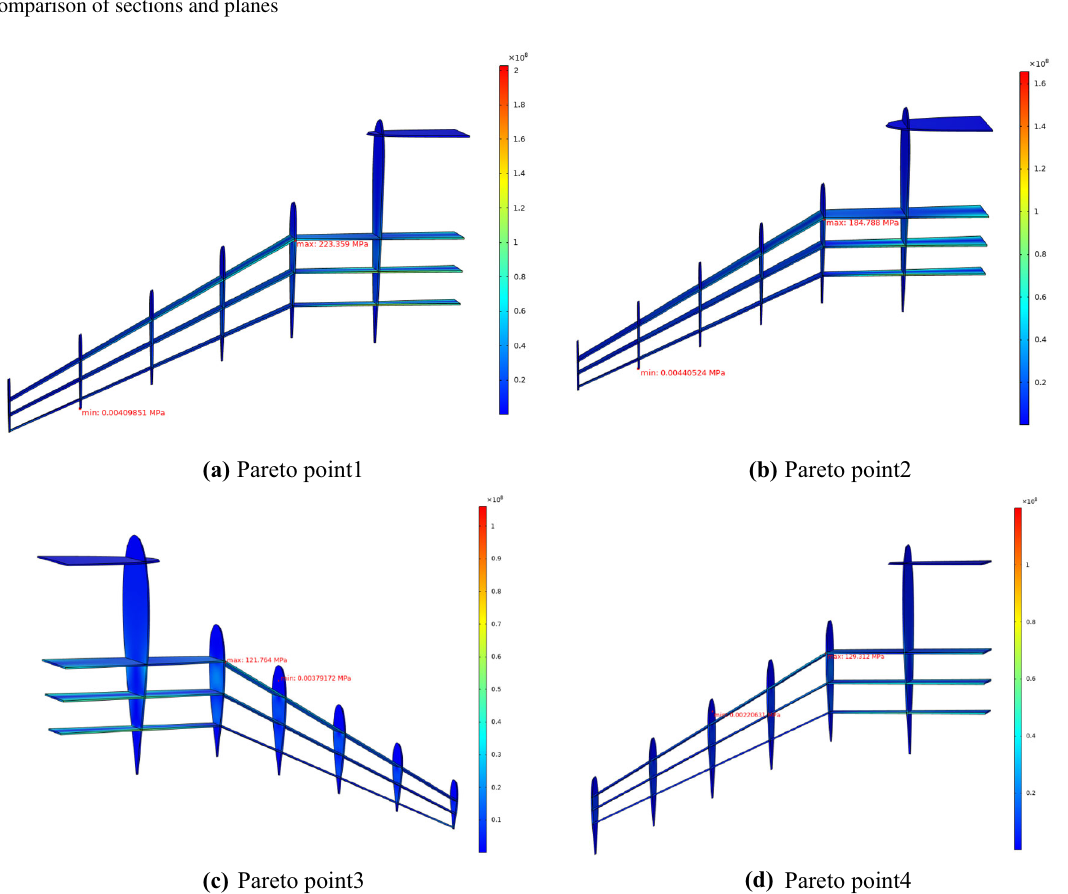
Fig. 21 Equivalent stress diagram